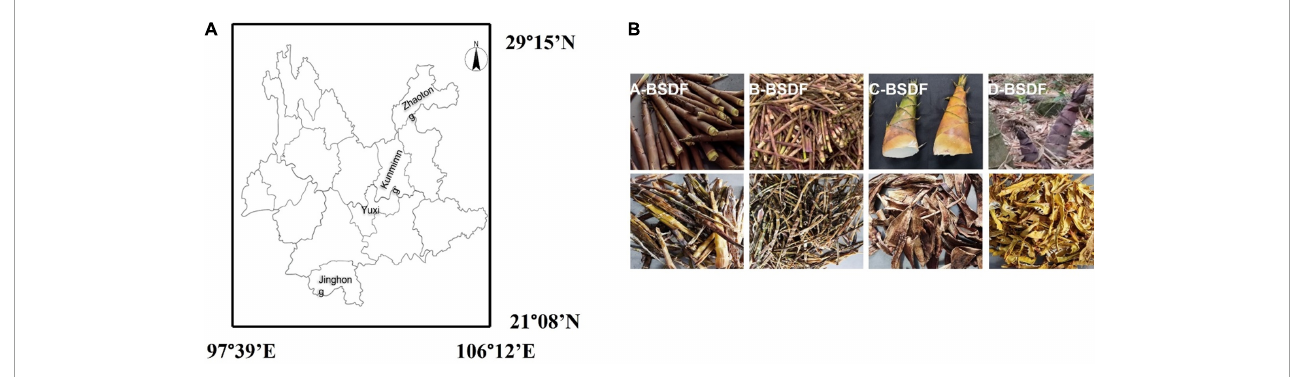
FIGURE1 Geographical locations of different bamboo shoot samples in Yunnan province of China (A) , extraction process of bamboo shoot dietary fiber (BSDF) (B) .